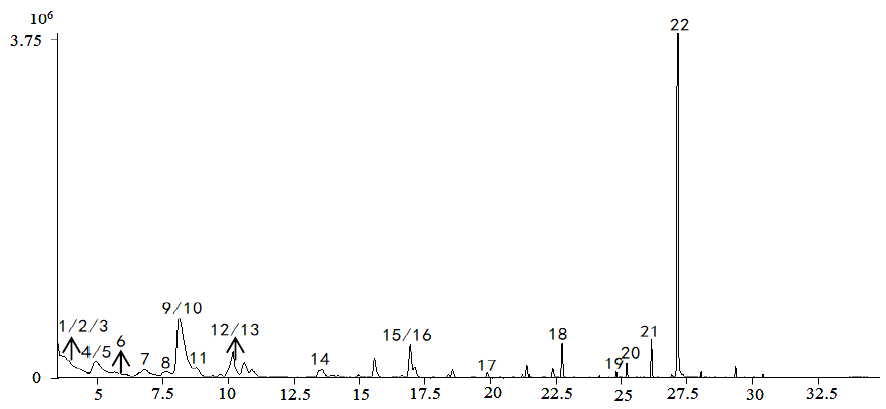
Figure 7. TIC of the sample, based on gas chromatography–mass spectrometry (GC-MS).